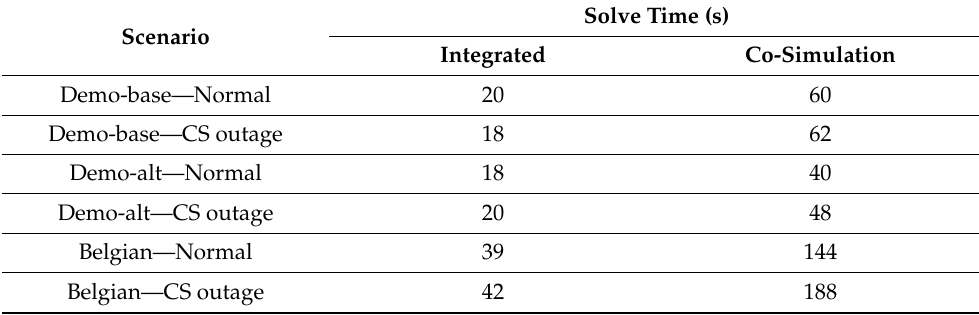
Table 4. Summary of model solve time for both the integrated and co-simulation